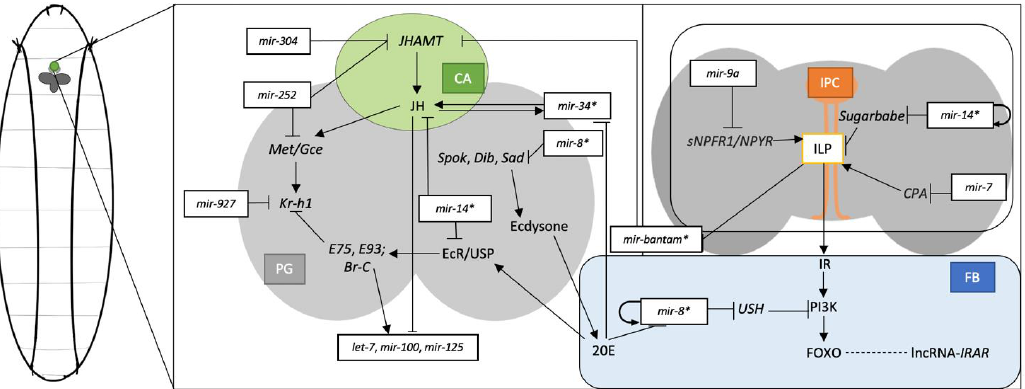
Figure 1. Drosophila larval hormonal signalling systems and metabolic systems represented with the juvenile hormone (JH), ecdysone, and insulin in the ring gland (RG), insulin-producing cells (IPC) from the brain, and adipose cells from fat body (FB). The RG is represented with corpus allatum (CA) coloured in green, prothoracic gland (PG) in light grey, IPCs in orange, the brain in dark grey, and fat body (FB) in blue. MiRNAs regulation on the specific pathways are represented throughout the pathways.